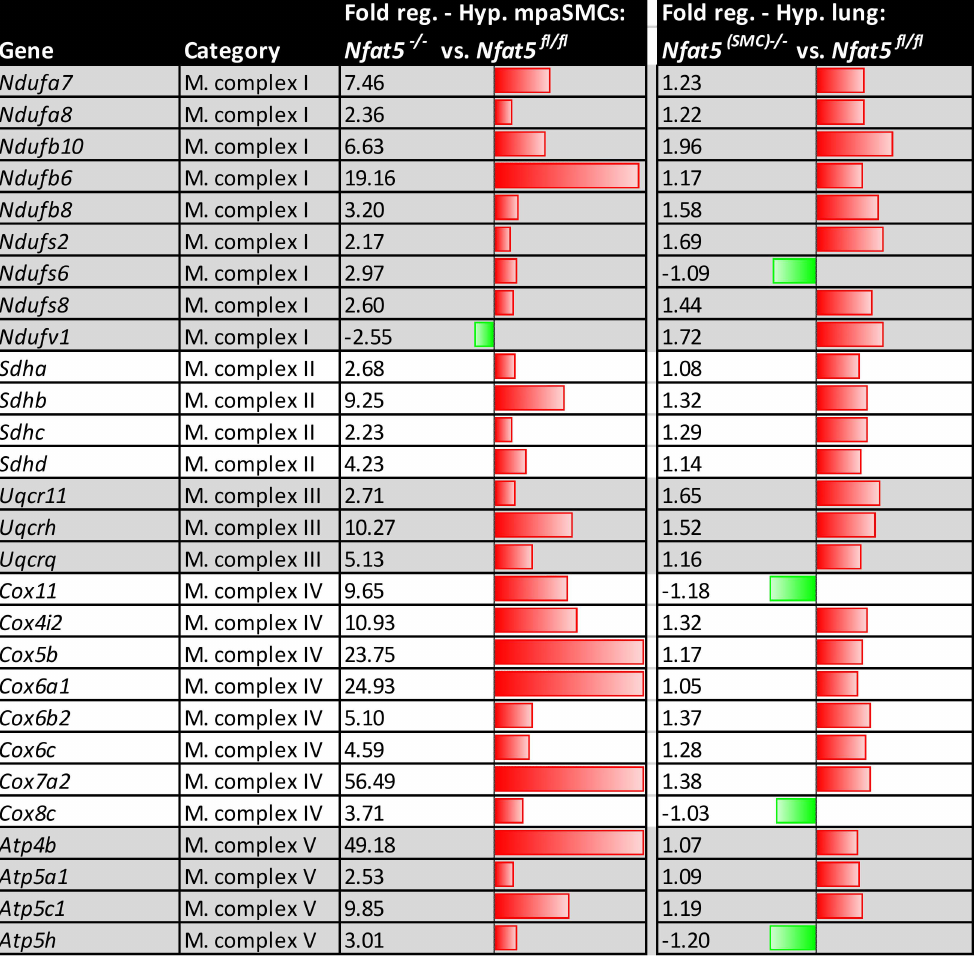
Figure 5. AnalysisoftheOXPHOS-dependentgeneexpression. ResultsofaqPCRscreening(RT 2 profilerPCRarray, Mitochondrial Energy Metabolism PAMM-008ZR, Qiagen) of mpaSMCs, which were treated with adenoviral vectors (AdCRE) to knockout Nfat5 ( Nfat5 − / − ) or AdPl vectors as control ( Nfat5 fl/fl ) and exposed to hypoxia for 24 h (left panel). The expression regulation of corresponding genes in hypoxic lungs (7 d) of Nfat5 fl/fl and Nfat5 (SMC) − / − mice is shown in the right panel (FR—fold regulation, at least two-fold regulated genes are shown in the left panel, upregulated: red, downregulated: